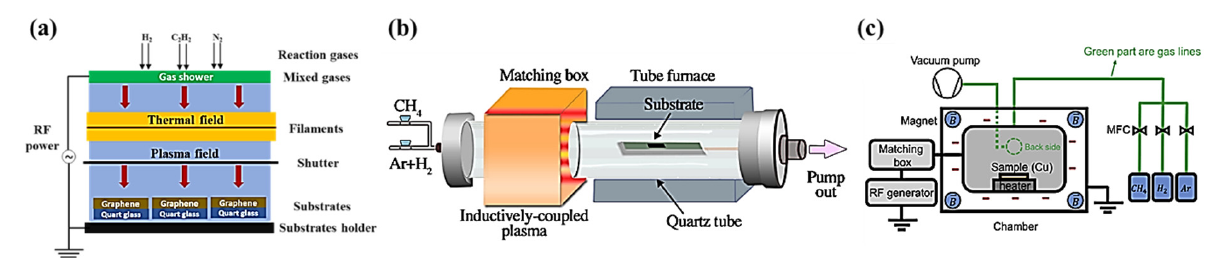
Figure 15. A graphical presentation of the RF-PECVD setup complemented with ( a ) HF, ( b ) ICP, and ( c ) CCP. Recreated with permission from [100–103].